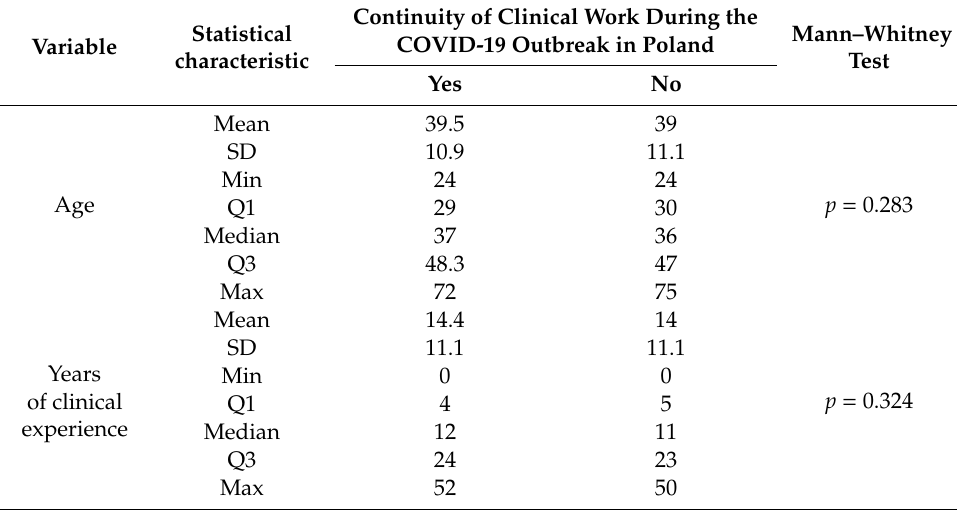
Table 5. Continuity of clinical work during the COVID-19 outbreak in Poland vs. age and years of clinical experience. Non-parametric statistical analysis, Mann–Whitney test ( p = 0.283; p = 0.324).